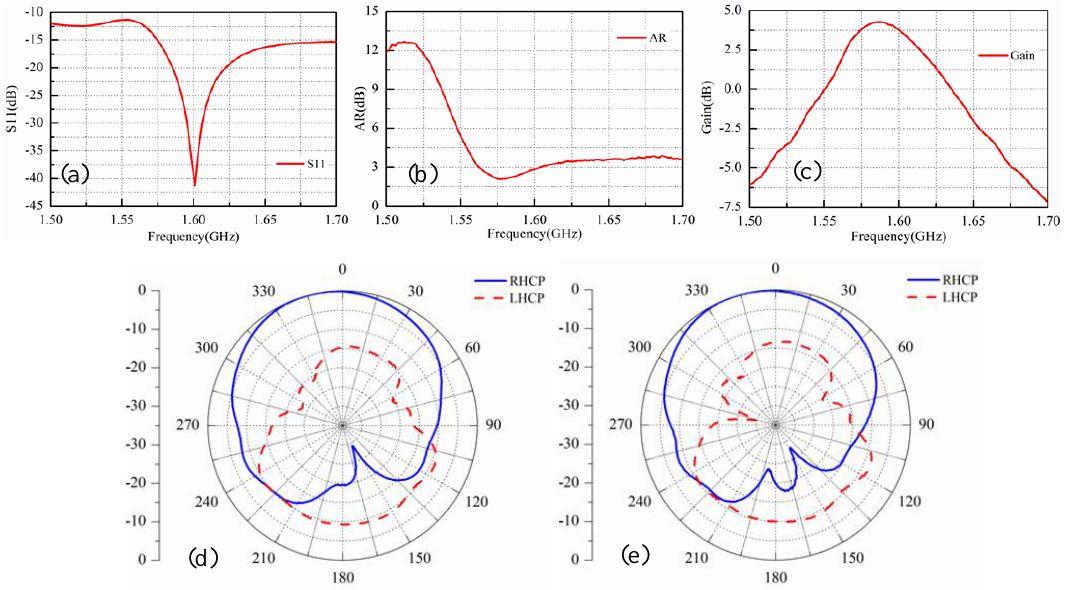
Figure 6. The measured results of the GPS/GLONASS dual-band antenna: ( a ) reflection coefficient, ( b ) axial ratio, ( c ) gain, normalized radiation patterns of ( d ) GPS band, and ( e ) GLONASS